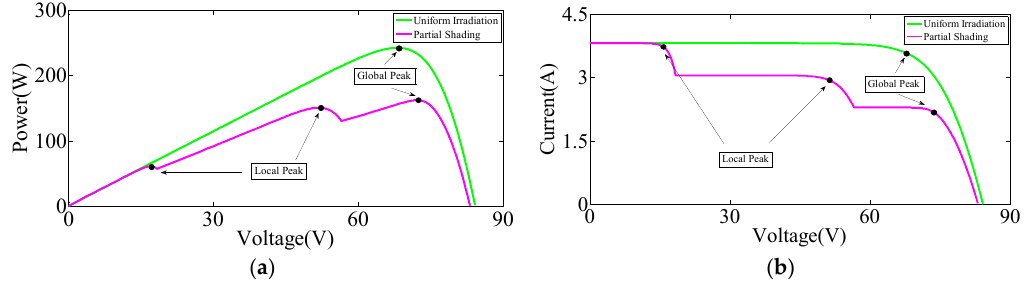
Figure 2. The configuration structure of the PV array ( a ) uniform irradiation; ( b ) partial shading.